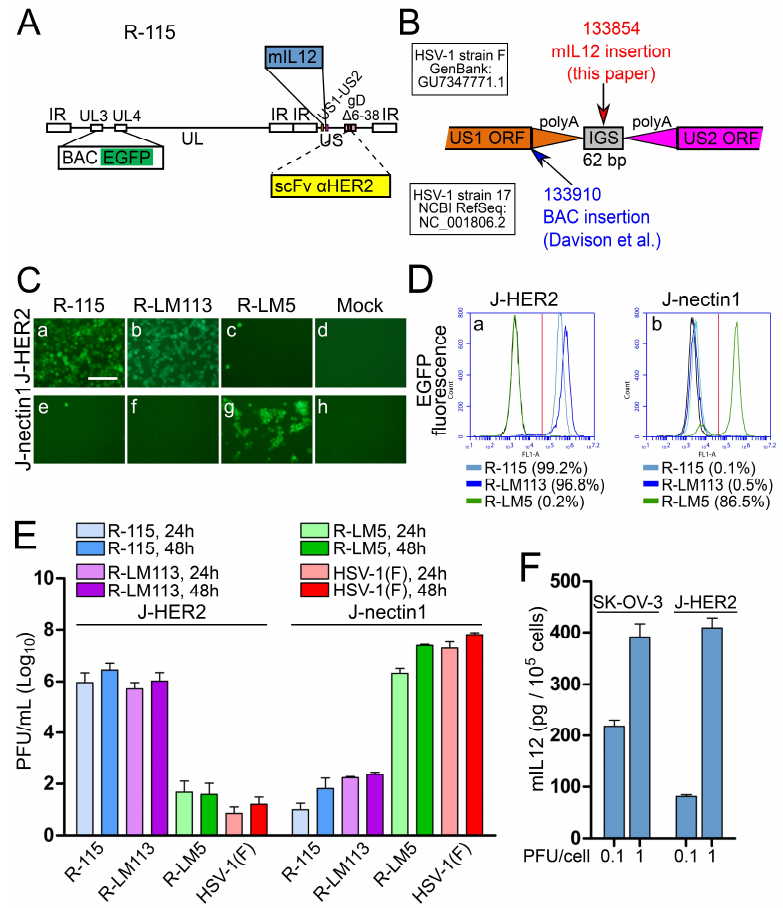
Figure 7. Properties of the HER2-retargeted R-115 expressing mIL12. ( A ) Genome organization or R-115. The scFv to HER2 is in gD, in place of aa 6–38; pBeloBAC11 and EGFP (BAC EGFP) are inserted between UL3 and UL4 [50]; the mIL12 cassette was cloned between US1 and US2. ( B ) Details of the US1-US2 intergenic region. PolyA addition sites are depicted as triangles. The coordinate for HSV-1(F) (GenBank: GU734771.1) and HSV-1 strain 17 (NCBI RefSeq: NC_001806.2) are above and below the diagram of the genes, respectively. The coordinates in red and blue indicate the site of insertion used in this study and by Davison et al. (GenBank: FJ593289.1), respectively. ( C ) J-HER2 or J-nectin1 cells were infected with the indicated viruses at 10 PFU/cell. Pictures were taken at 24 h p.i. The pictures relative to the controls (R-LM5 and Mock in J-nectin1) are the same as shown in Figure 2C and 4C, since the experiments were run in parallel. The levels, brightness, and contrast of the panels were adjusted by means of Adobe Photoshop as follows: input level (black) 30, brightness +60, contrast +60. Scale bar = 100 μm. ( D ) J-HER2 or J-nectin1 cells infected as in panel C and analyzed by flow cytometry for EGFP detection. The controls R-LM5 and Mock (black line) in J-nectin1 were presented in Figure 2D and 4D, as the experiments were run in parallel. The figures next to each virus name indicate the percentage of infected cells. Vertical red line: threshold discriminating the negative and positive populations, as determined by comparison with the negative control. ( E ) R-115 replication in J-HER2 and J-nectin1 cells, infected at 0.1 PFU/cell and harvested at 24 and 48 h after infection. Histograms represent the average of three independent experiments ± SD. ( F ) Quantification of mIL12 secreted in the media of R-115-infected SK-OV-3 or J-HER2 cells, 24 h after infection at 0.1 and 1 PFU/cell. The bars represent the averages of triplicates ±